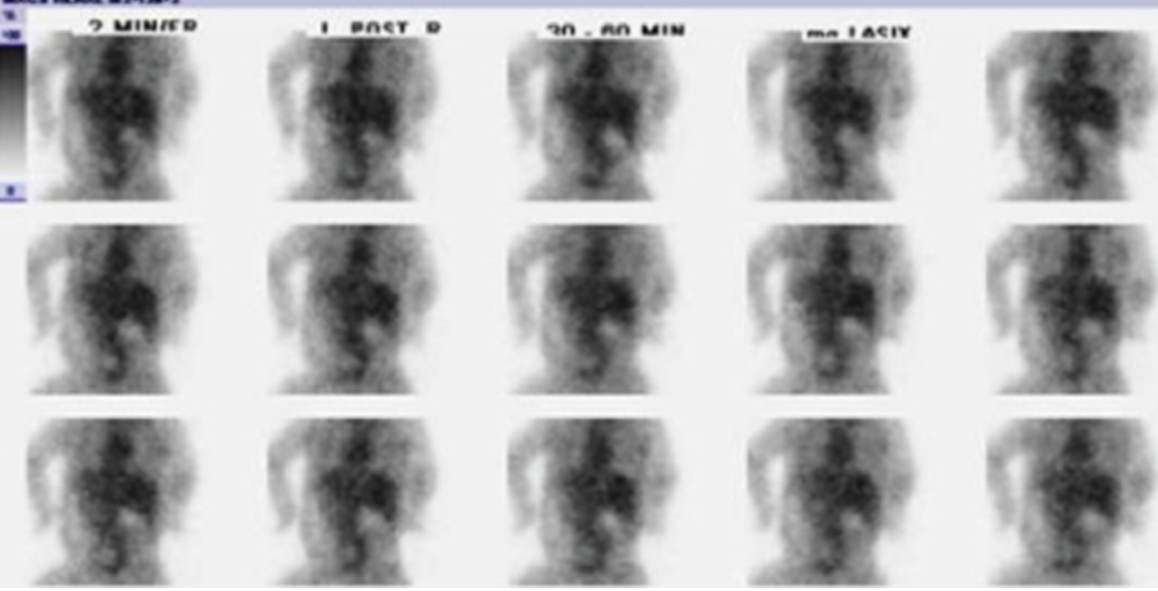
Figure 2: Sequential posterior planar images from MAG3 scan showing no perceptible renal activity. A large amount of other soft tissue activity/blood pool activity is